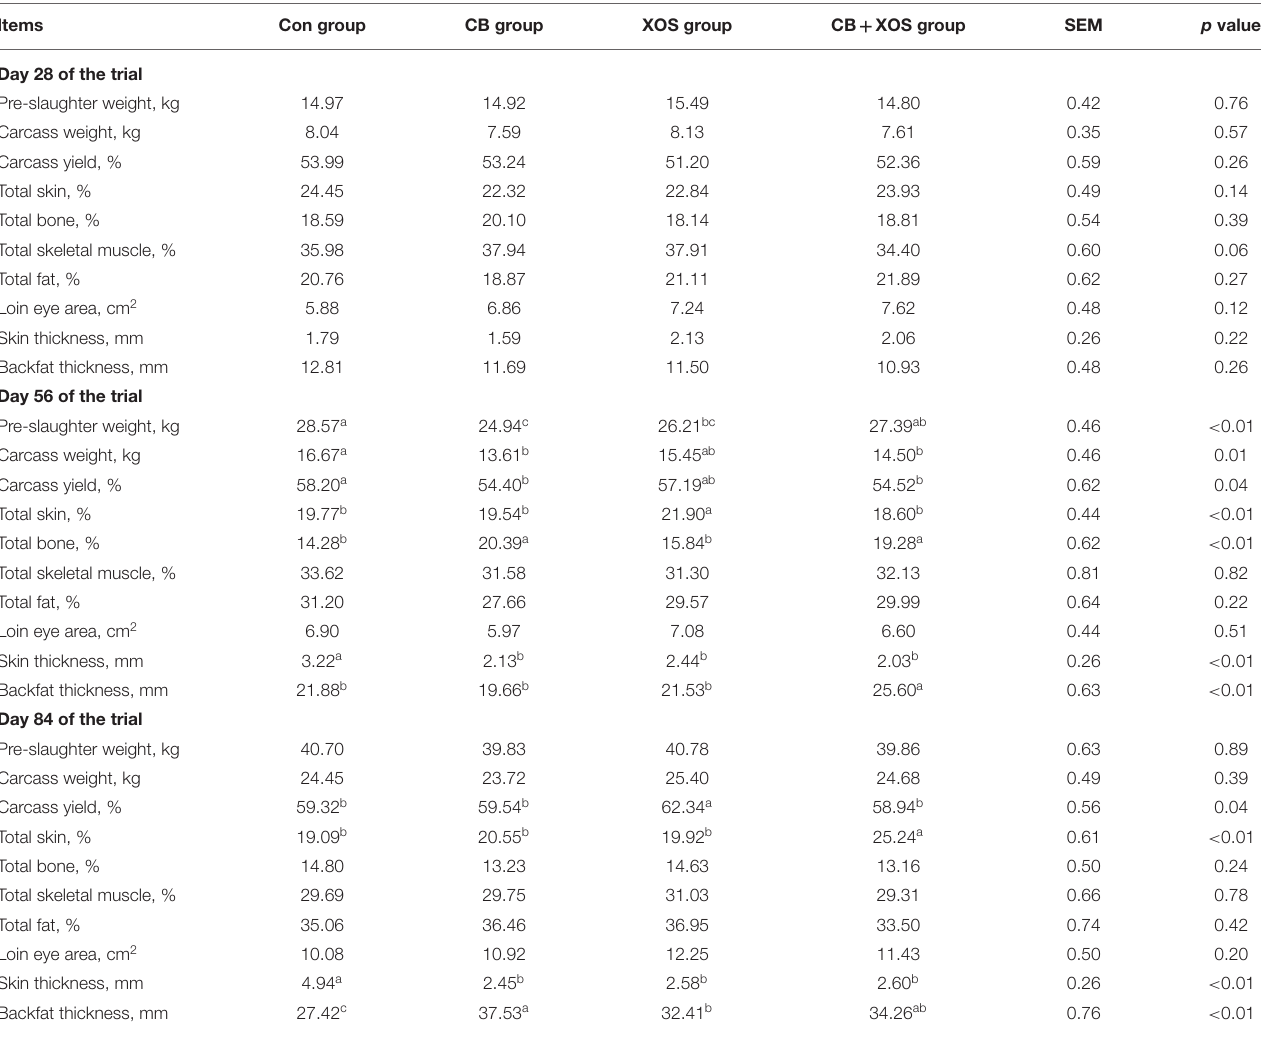
TABLE 3 | Effects of dietary addition with CB and XOS on carcass traits of Huanjiang mini-pigs.